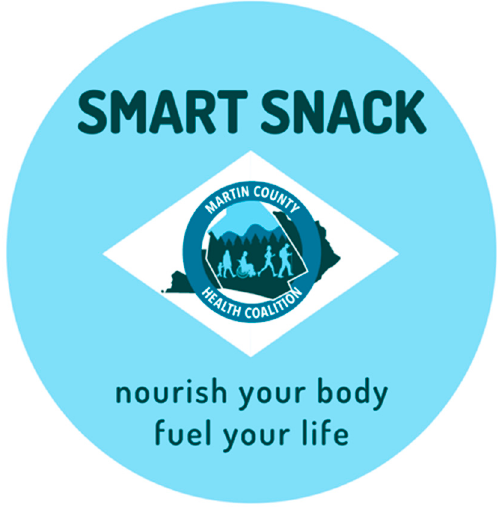
Figure 1. Smart Snack shelf-wobbler placed in gas stations ( n = 5).